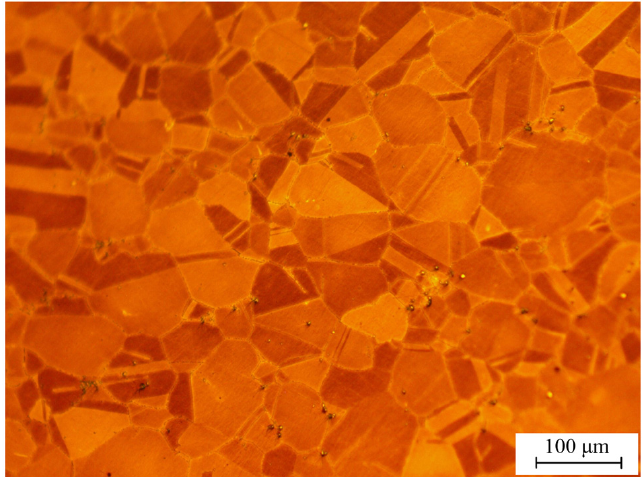
Figure 12. Initial microstructure of the GH4169.